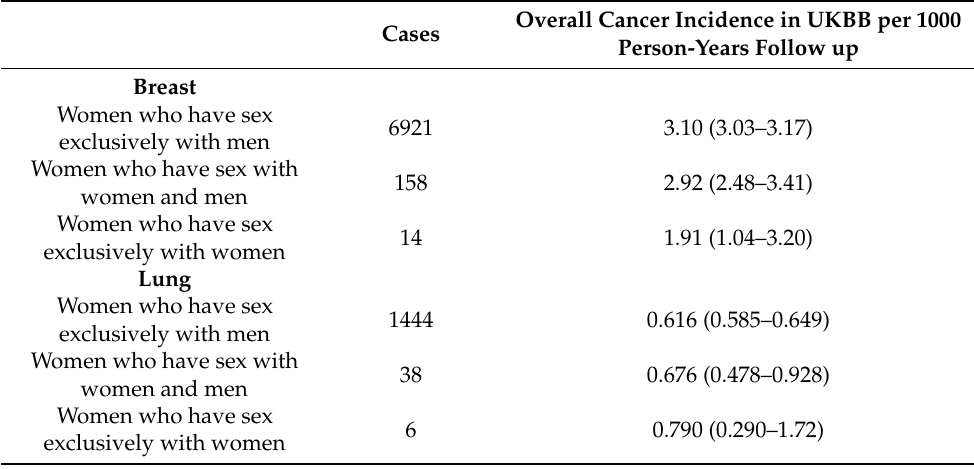
Table 2. Incident cancer case numbers, and incidence rates in women, stratified by sexual